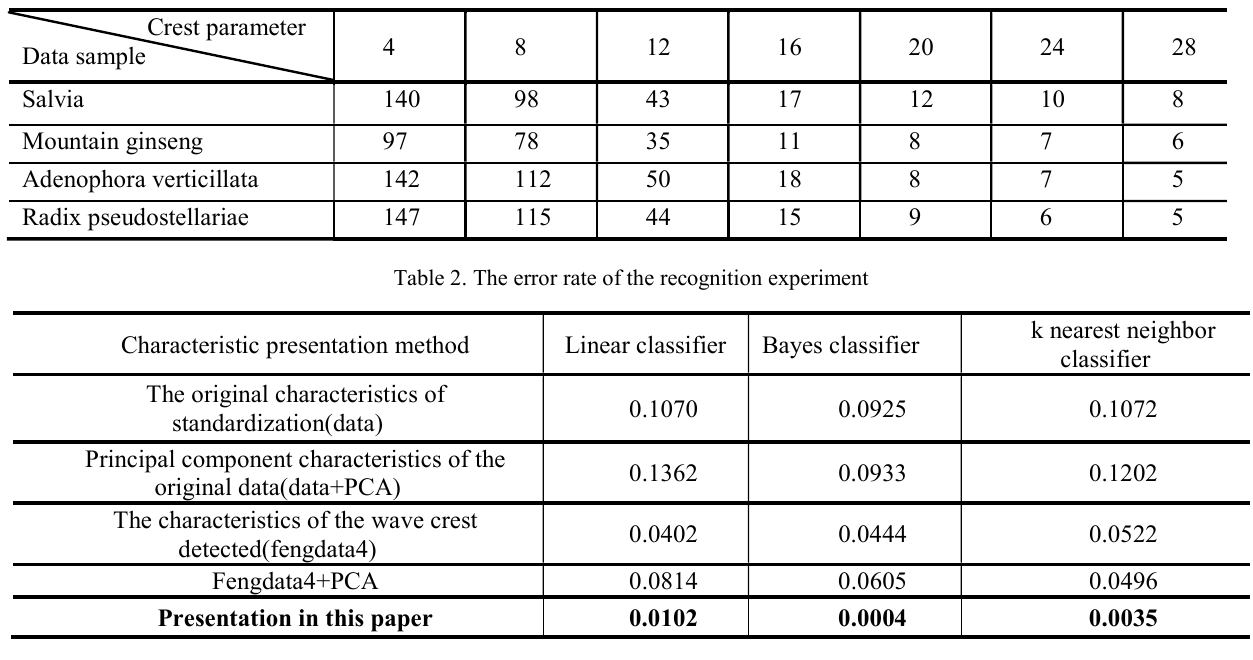
Table1. The number of spectral peaks detected of Ginsengs